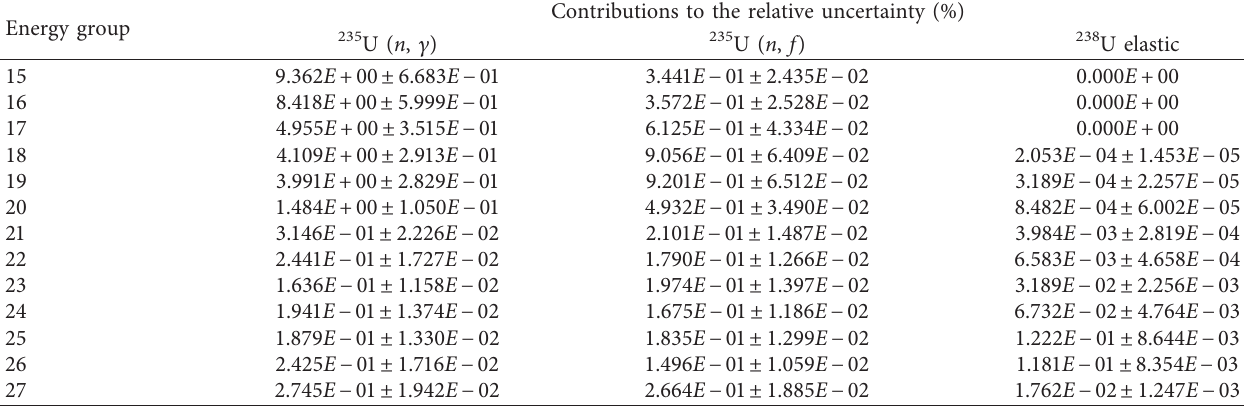
Table 2: The top 3 sources of uncertainty in 235 U effective resonance absorption